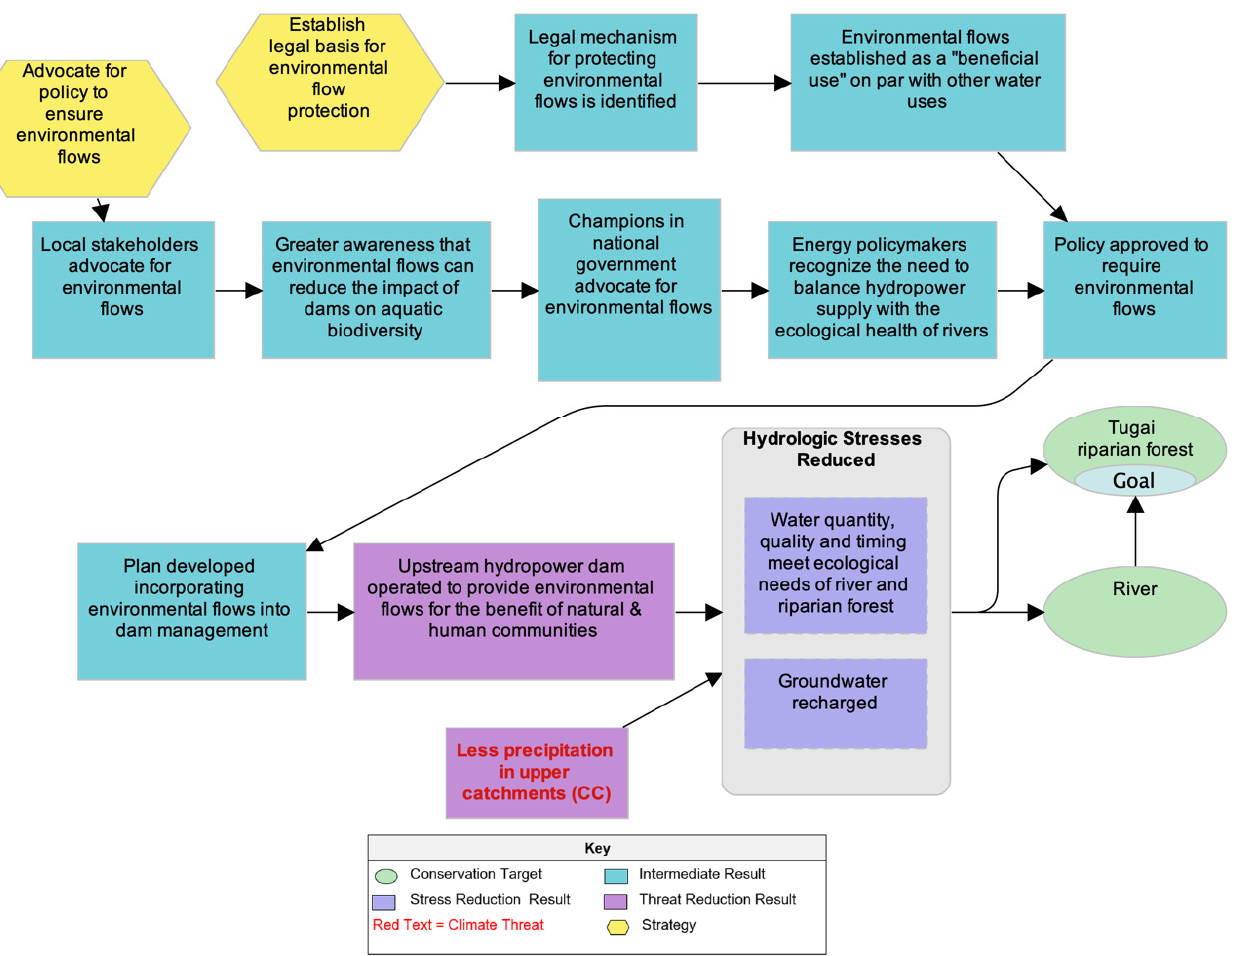
Figure 7. Tugai Nature Reserve Example Results Chain for a Policy to Ensure Environmental Flows (adapted with permission from ref. [25]).